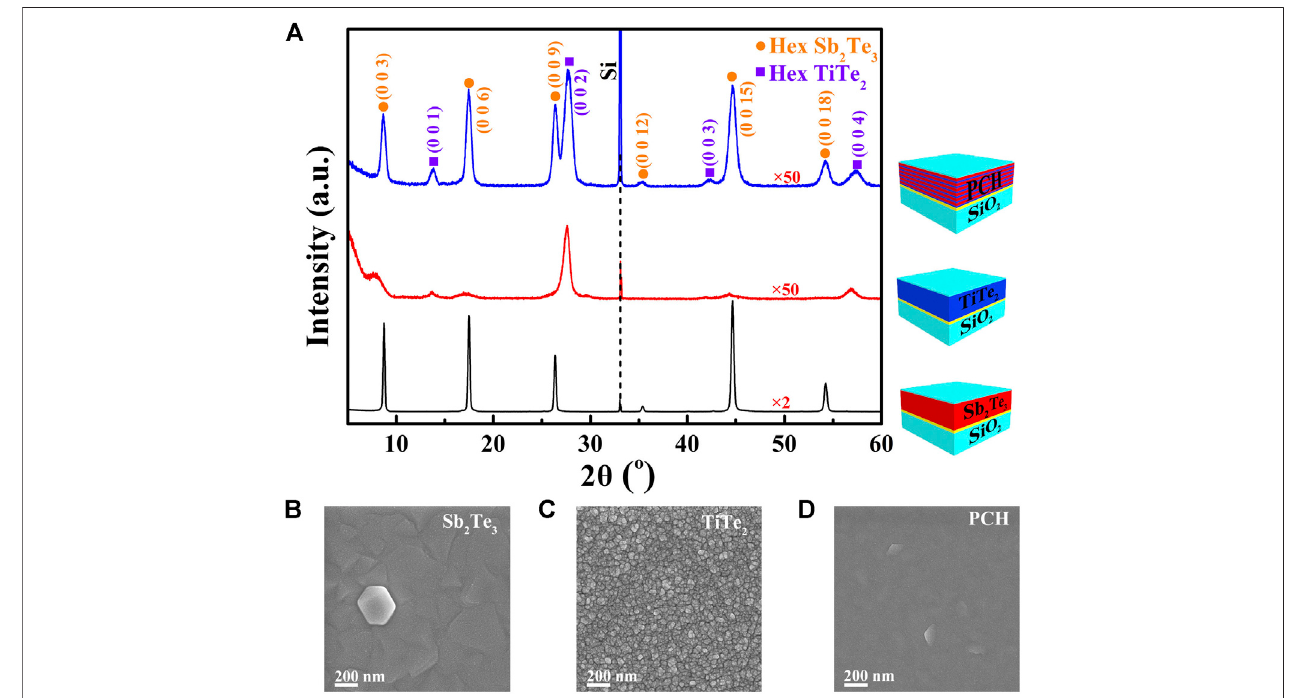
FIGURE 2 | (A) XRD curves of ∼ 100 nm thick Sb 2 Te 3 , TiTe 2 , and PCH fi lms sandwiched between SiO 2 layers ( see corresponding sketch). All the fi lms were depositedat 300 ° C on thepregrown seed layer (yellow thin layer in each sketch), exhibiting hexagonal(Hex) lattice con fi guration with strong c -axis (0 0 l ) orientation. For the sake of better observing the weak diffraction peaks, the diffraction intensity is multiplied by 2 for the Sb 2 Te 3 curve and 50 for the TiTe 2 and PCH curves. (B – D) SEM images of the in situ heating deposited Sb 2 Te 3 , TiTe 2 , and PCH fi lms, respectively.